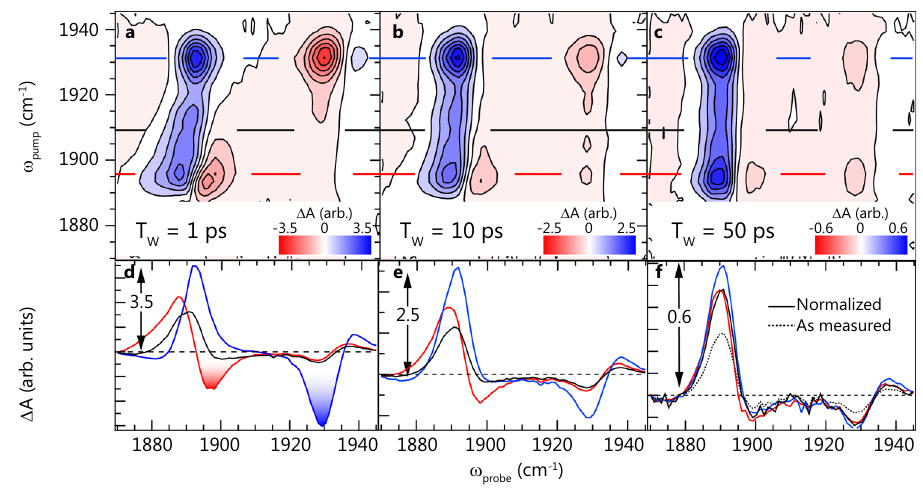
Fig. 2 2D IR spectroscopy of cavity-coupled SNP. Two-dimensional infrared spectra of the NO stretching band strongly coupled to an optical mode of a 25 μ m-long Fabry – Pérot cavity measured at a 1 ps, b 10 ps, and c 50 ps waiting times. The intensity scale is in units of normalized − log( T / T 0 ), with blue positive (decreased transmission) and red negative (increased transmission). Solid colored lines represent the pump frequencies used for the spectral cuts in panels d , e , and f . The blue trace is taken where the pump frequency coincides with the UP, the black trace corresponds to the reservoir, and the red trace corresponds to the LP. In addition, f shows the normalized reservoir slice (solid black trace) and the unnormalized reservoir slice (dashed black trace). The Rabi splitting in this data is 35 cm − 1